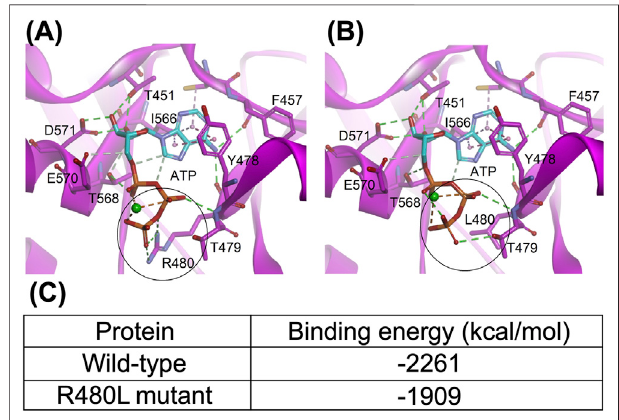
FIGURE 6 | Structure of the CNNM-PRL complex (PDB code: 5LXQ). (A) and (B) , the wild-type and R480L mutant CBS module of CNNM2, respectively. The dashed lines represent the hydrogen bond (green), electrostatic (orange), andhydrophobic(pink)interactions.Themetal ion is shown as a green sphere. The black circle highlights the mutation site; (C) indicatesthatthismutationintheCBSmoduleresultsinsigni fi cantimpairment of the binding ability with